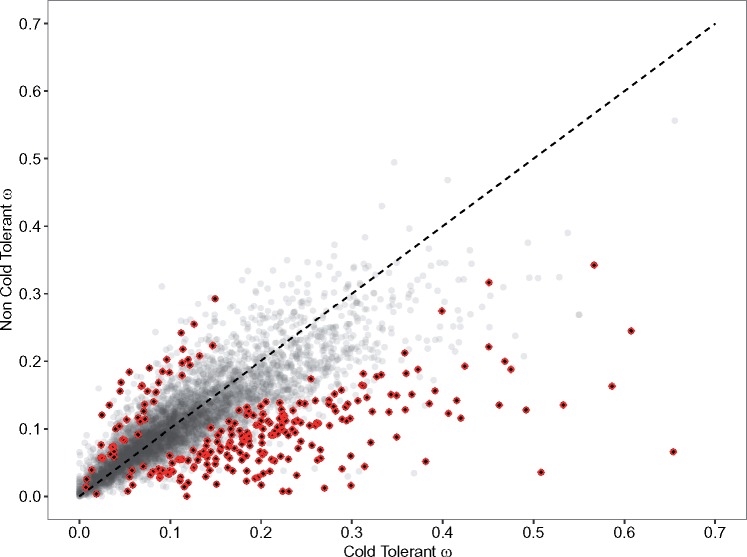
—The relationship between values of ω estimated for 5,619 genes in cold-tolerant and non-cold-tolerant species of Drosophila. 250 genes with significantly different estimates of ω are shown in black with red outline. Diagonal line indicates the 1–1 diagonal, points below the diagonal line show elevated levels of ω in cold-tolerant species compared with non-cold-tolerant species, whereas points above the diagonal show elevated levels of ω in non-cold-tolerant species.